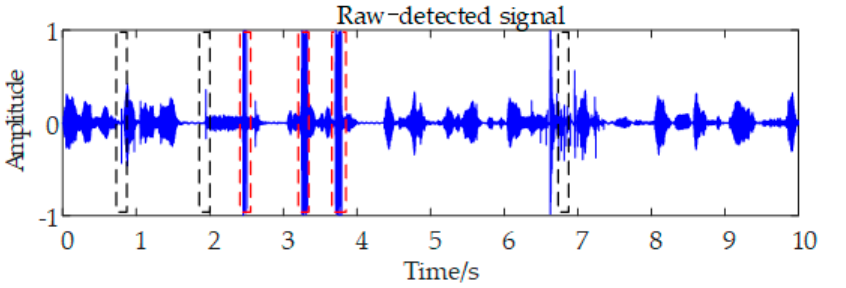
Figure 3. Raw-detected signal with speckle noise.